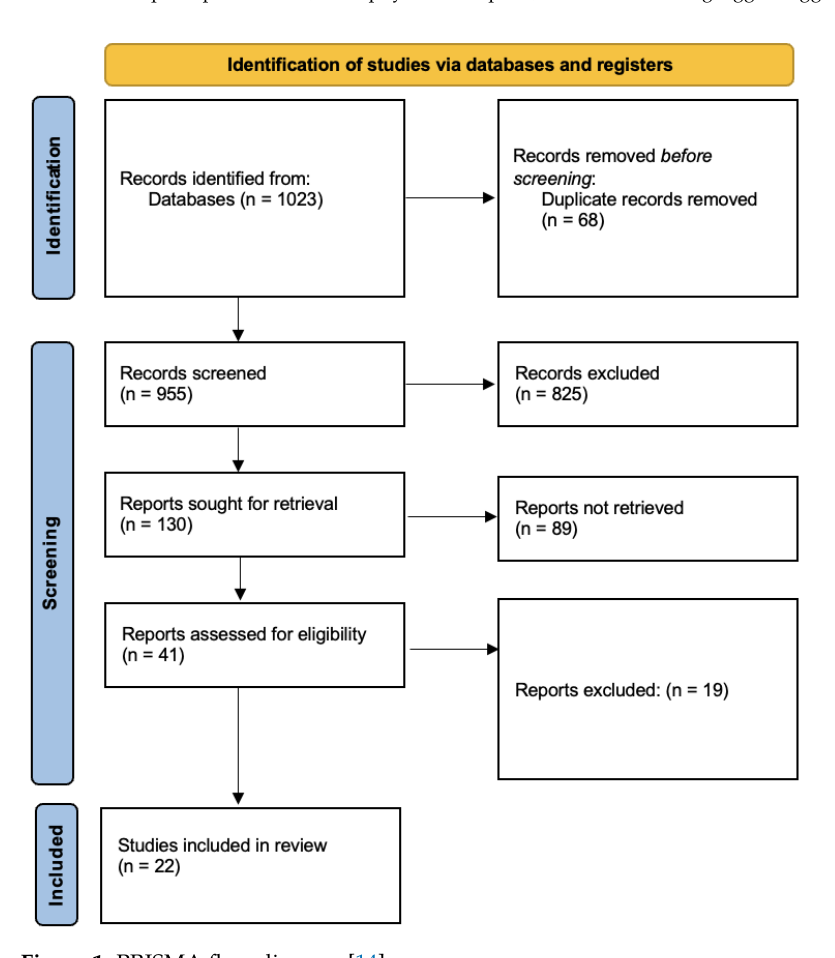
Figure 1. PRISMA flow diagram [14]. Table 1. Overview of studies.